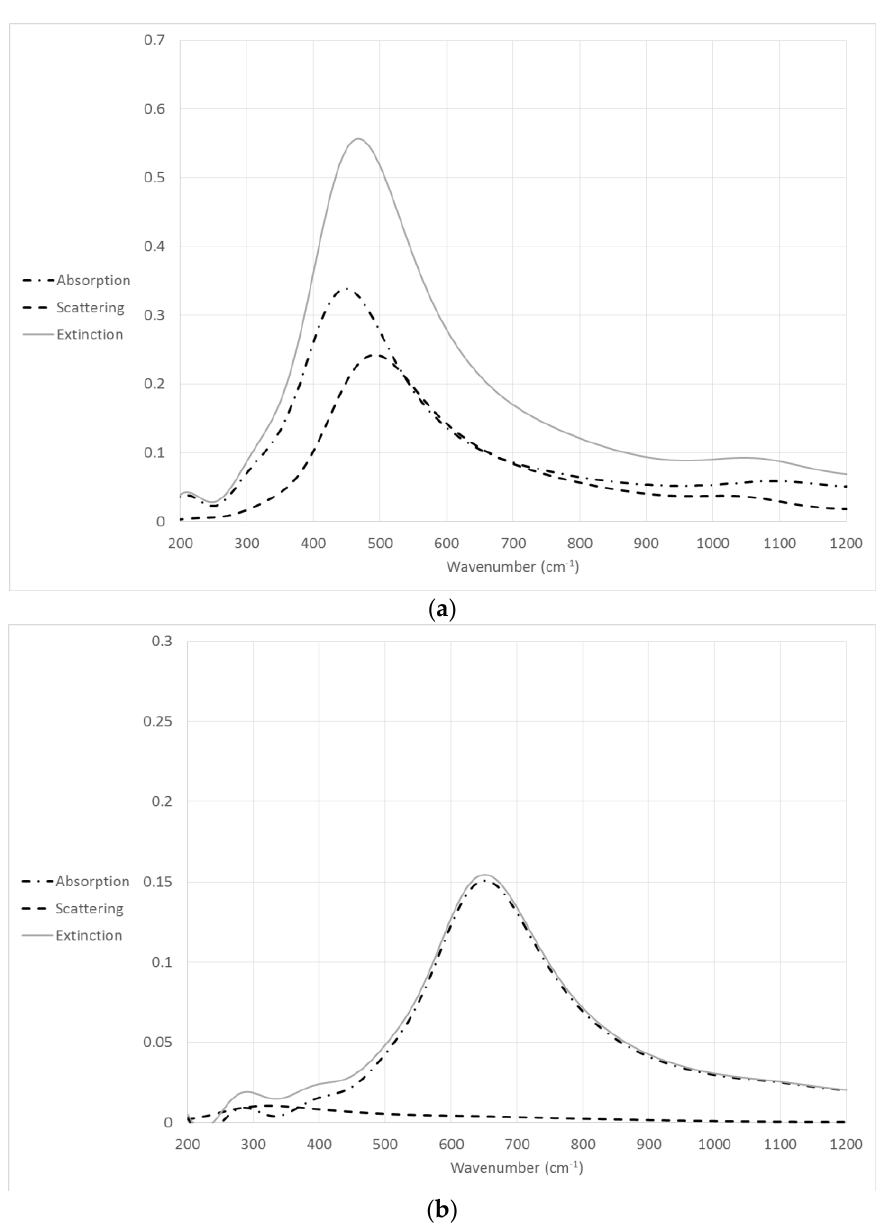
Figure 5. Spectral response for rectangular doped Ge particles (material 2 in Table 2) for ( a ) height 0.5 μm and ( b ) height 0.1 μm. The length is 2 μm and the width is 1 μm in both cases.